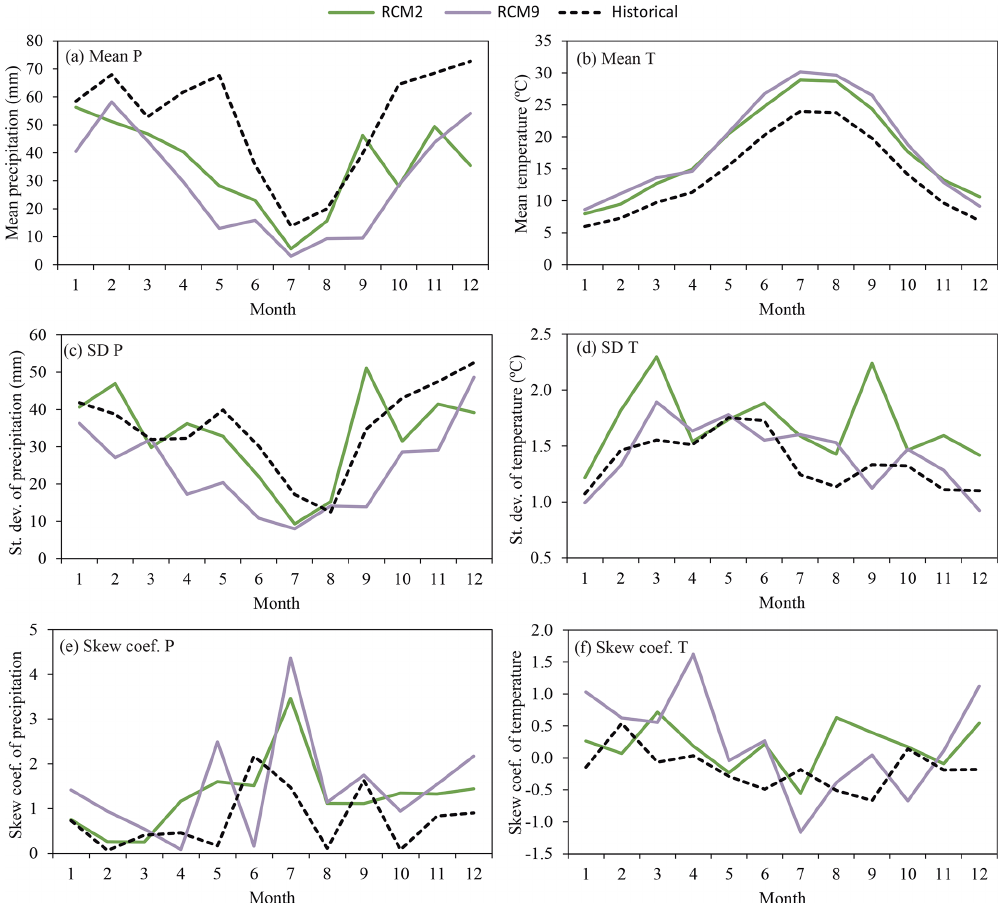
Figure 10. Monthly mean, standard deviation and skew coefficient within the mean year of the historical period (1972–2002) and future horizon (2071–2100) series (RCM2 and 9) for precipitation (a, c, e) and temperature (b, d, f)